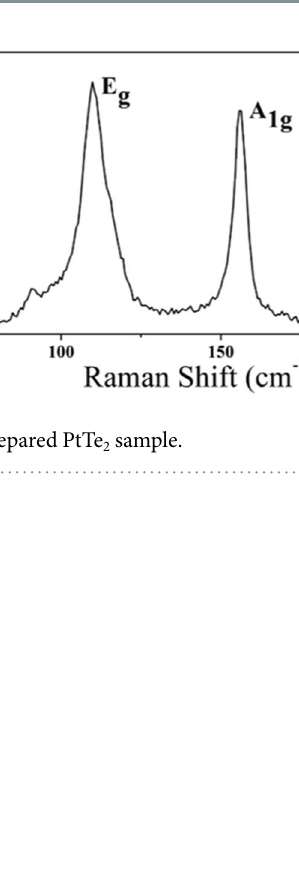
Figure 6. The schematic experimental setting of the passive Q-switching Yb-doped fiber